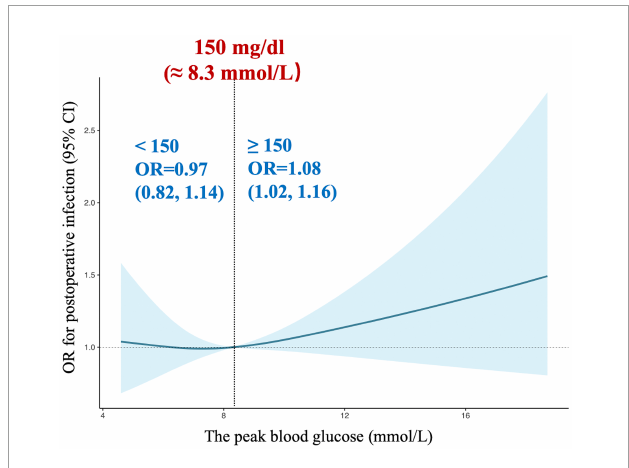
FIGURE4 Association of intraoperative peak glucose with postoperative infection. OR, odds